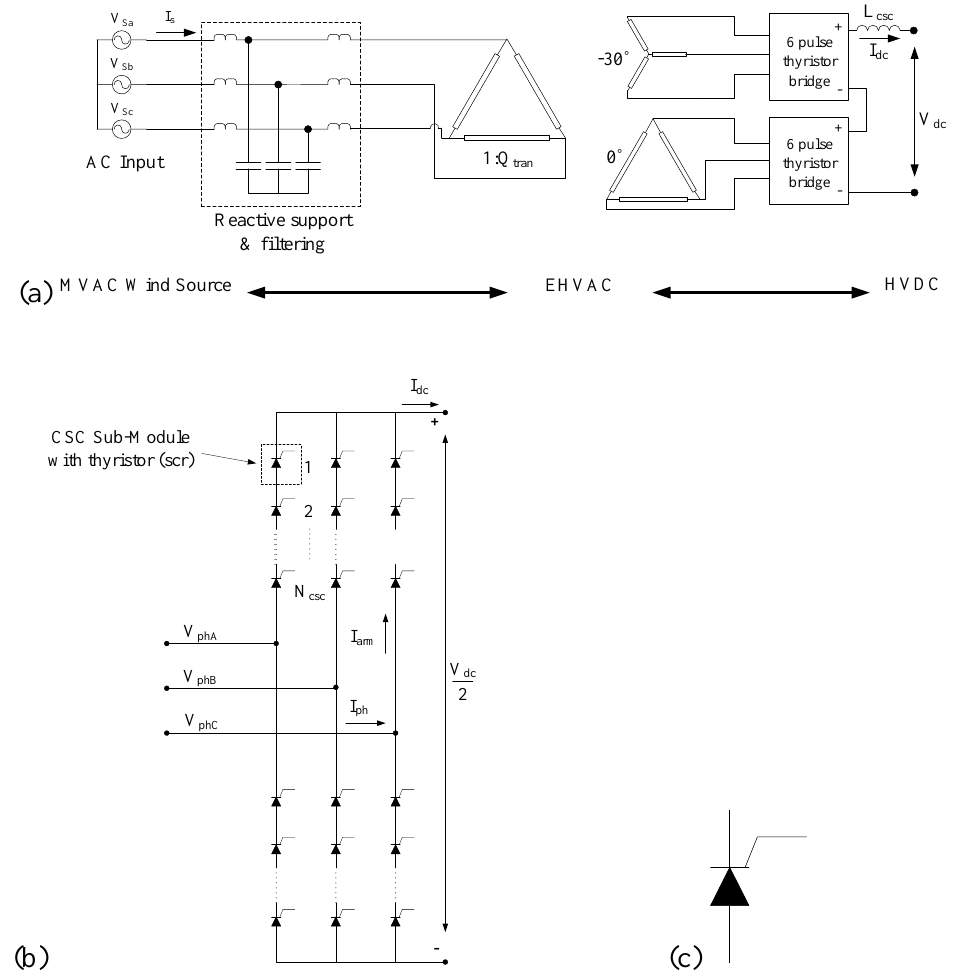
Figure 2. (a) Simplified schematic of the typical 12-pulse CSC implementation for HVDC (b) a 6 pulse thyristor bridge (c) thyristor (SCR)